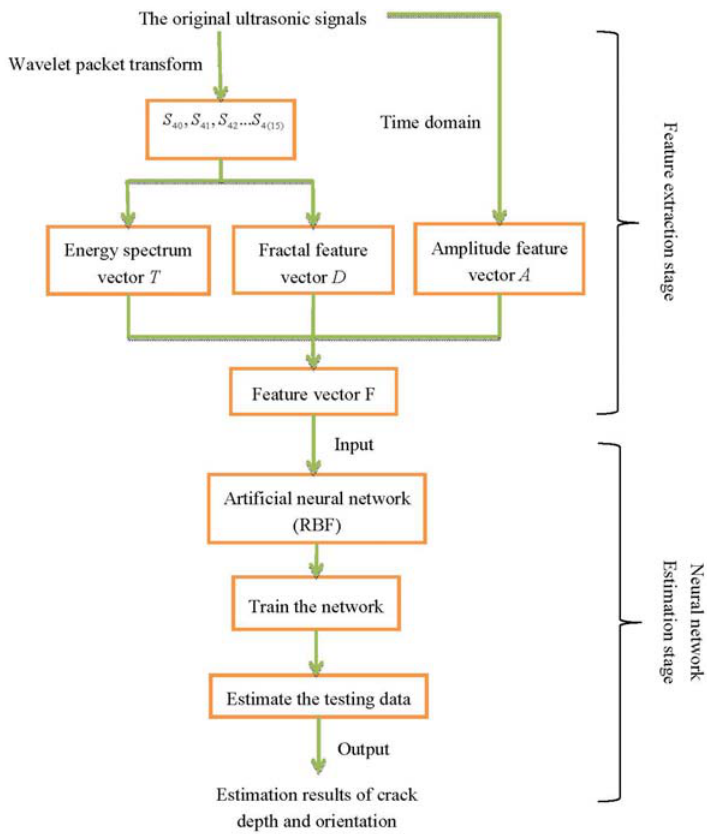
Figure 9. The flowchart of the presented estimate